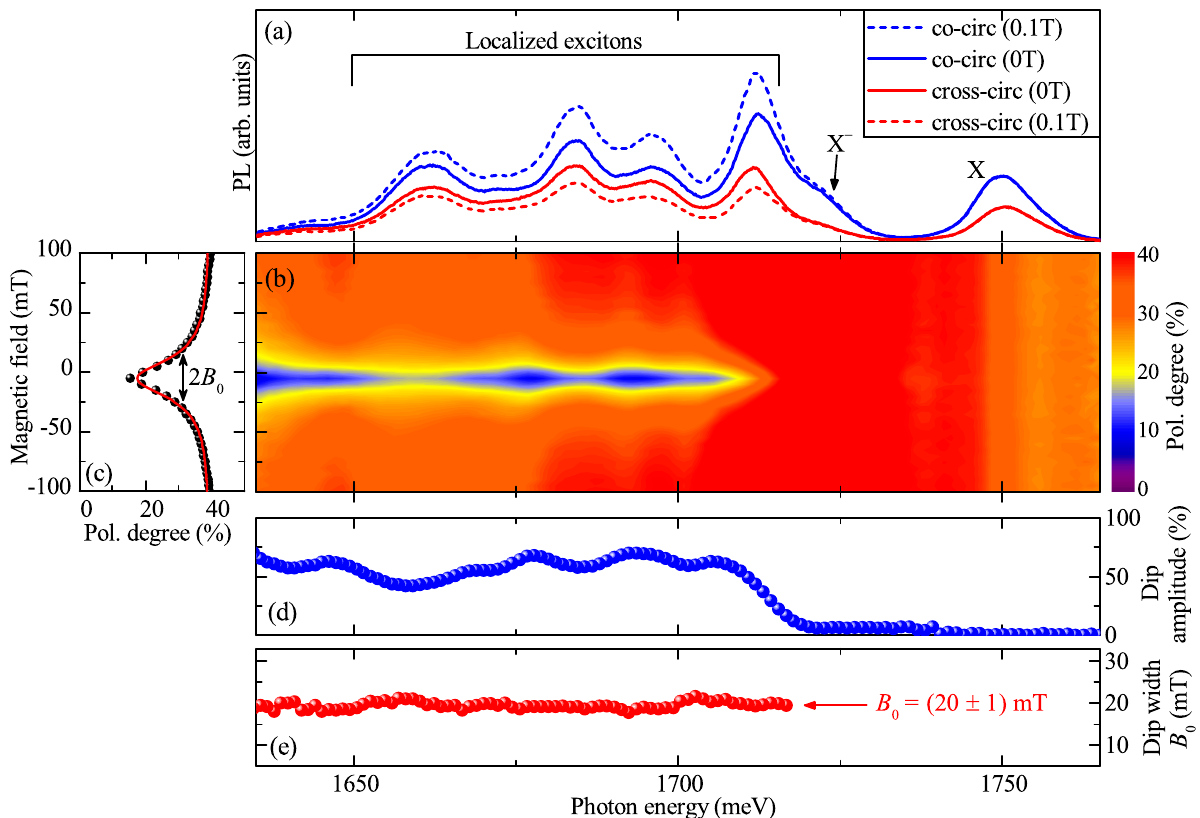
FIG. 1. (a) PL spectra of a representative WSe 2 monolayer (at T ¼ 6 . 5 K) excited with the σ − polarized light at E ¼ 1915 meV. The spectra were measured at zero field (solid lines) and at a magnetic field of 100 mT applied in the Faraday geometry (dashed lines). For each field, the spectra were detected in the two circular polarizations of opposite helicities (as indicated). (b) Color-scale map presenting the circular polarization degree of monolayer WSe 2 PL as a function of magnetic field and emission energy. The plotted degree is obtained as an average of the two polarization degrees determined under the σ − and σ þ polarized excitation. A pronounced decrease of the polarization degree at zero field is visible in the energy range corresponding to the emission of localized excitons. (c) Cross section presenting the magnetic-field dependence of the circular polarization degree of the localized excitons PL integrated over the emission energy ranging from E ¼ 1650 meV to E ¼ 1715 meV. The solid line represents a fit with a formula P ð B Þ ∝ 1 − α = ½ 1 þ ð B − B Þ 2 =B 2 (cid:3) accounting for the Lorentzian-like field dependence of the valley pseudospin relaxation rate 0 rem in line with similar effects observed for real spins in conventional semiconductors [1,23 – 25]. The parameter α corresponds to the percentage amplitude of the magnetic-field-induced dip in the polarization degree, B 0 represents the HWHM of the dip, while B accounts for the remanent field of a superconducting coil. (d,e) The amplitude α (d) and HWHM B 0 (e) of the dip in the polarization degree determined for different emission